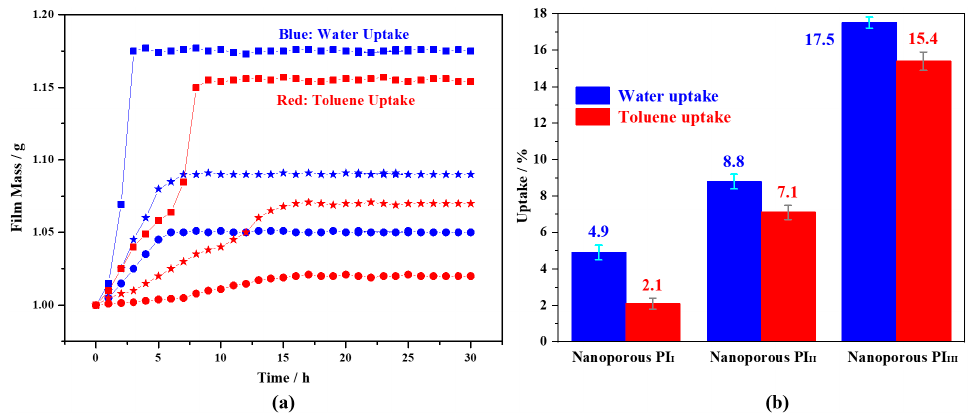
Figure 7. Uptake on water and toluene: ( a ), film mass–time curves, where sphere, star and square represent porous PI films (PI I , PI II and PI III ) from PI I - b -PS, PI II - b -PS and PI III - b -PS, respectively; ( b ), equilibrium uptake of porous PI films (PI I , PI II and PI III ) from PI I - b -PS, PI II - b -PS and PI III - b -PS. The porous PI films have higher uptake of water and toluene with an increase in f VPS value (that is actually the porosity). Porous films of PI I and PI II (derived from PI I - b -PS and